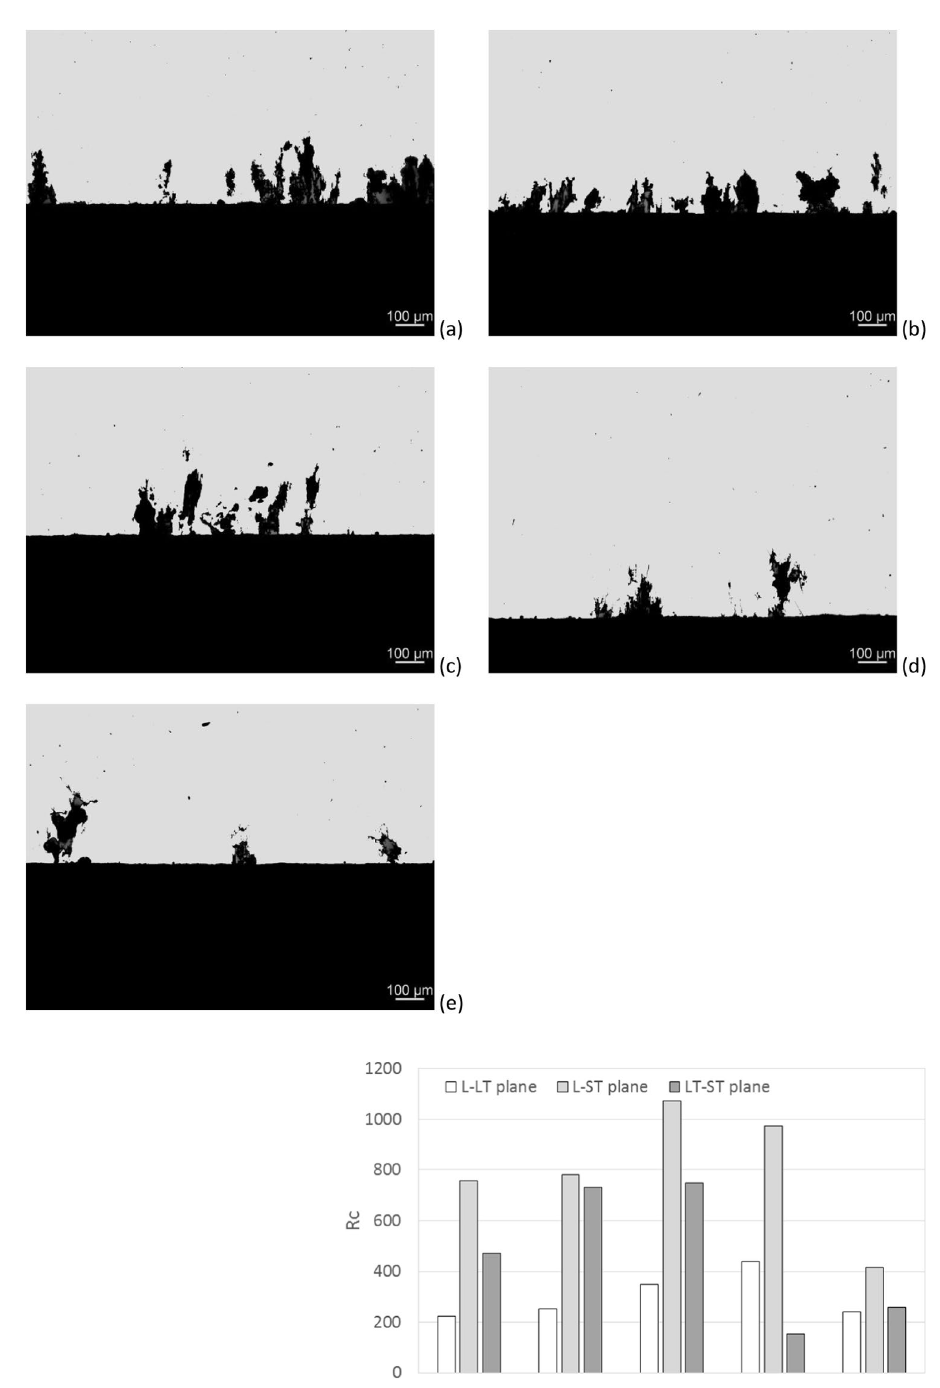
Fig. 7 Corrosion pits observed in the T7451C ( a ), T76 ( b ), T76C ( c ) and T76CS ( d ) speci- mens